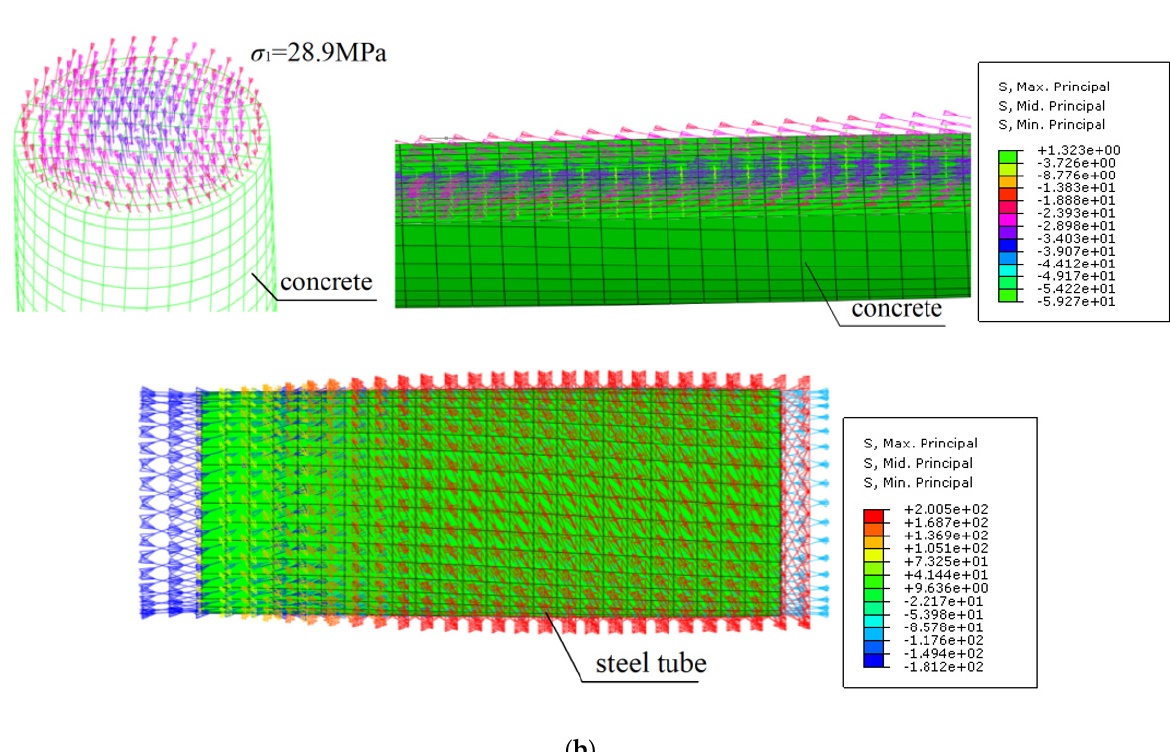
Figure 7. Stress state of the concrete and steel tube under pure torsion and compression-torsion: ( a ) n = 0; ( b ) n = 0.6.